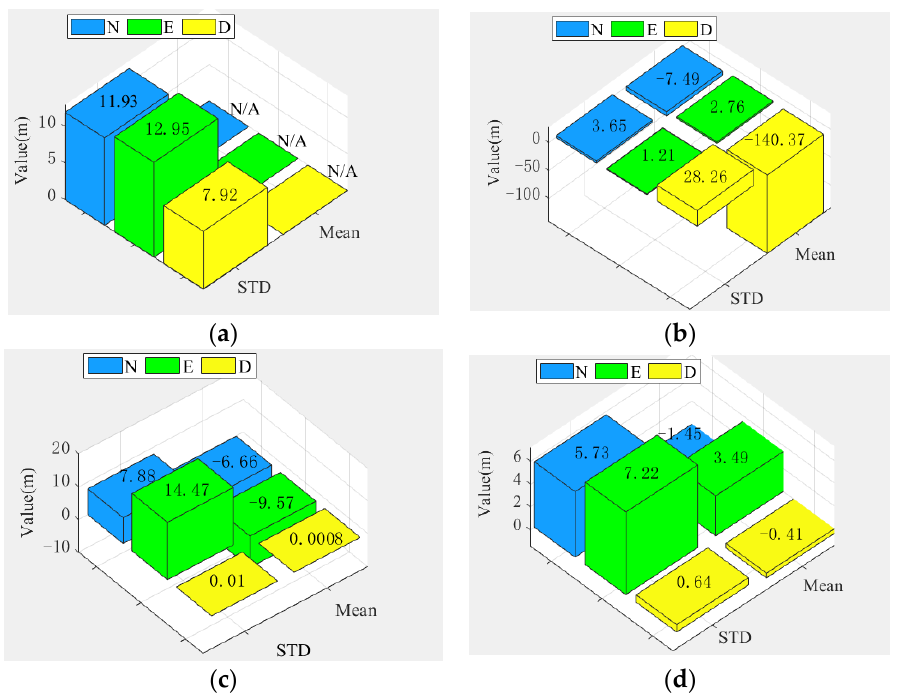
Figure 10. Histogram of position error statistics comparison. ( a ) Huang [39], ( b ) Hsu [40], ( c ) Ye [24], and ( d ) this paper.